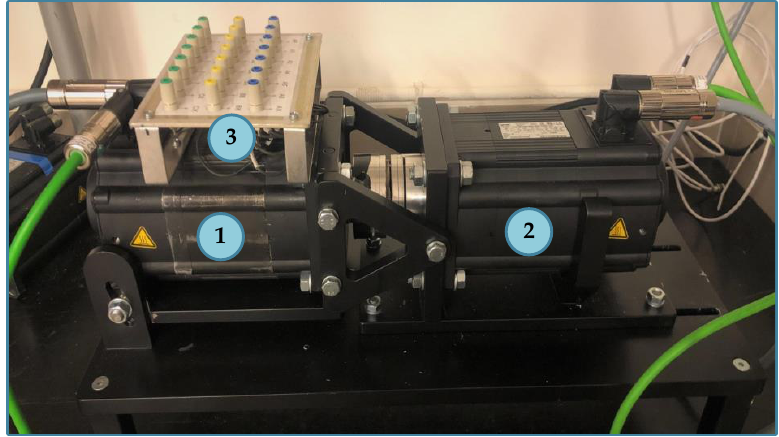
Figure 4. Real view of the experimental stand with (1) tested PMSM, (2) load PMSM and (3) board with the derived phase terminals of the stator winding.